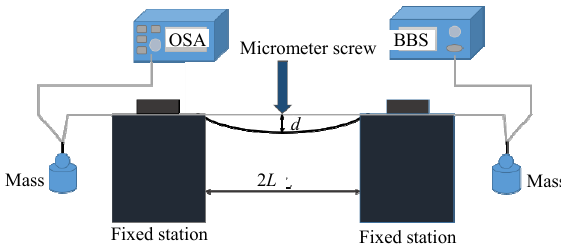
Fig. 4 Experimental setup diagram of the MZI sensor for curvature